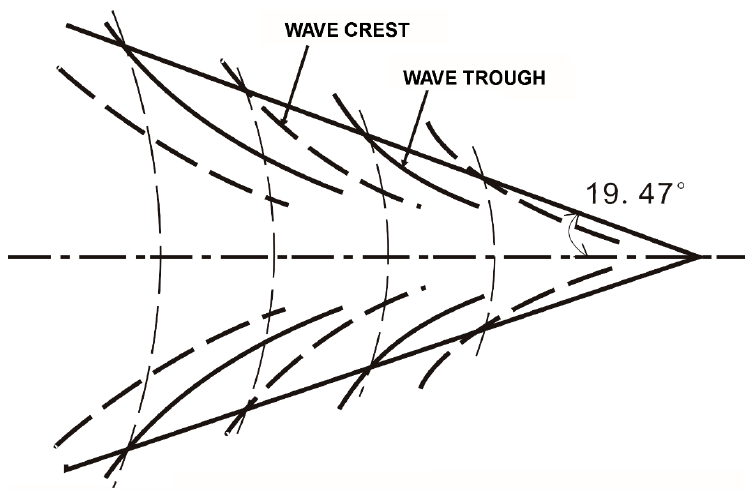
Figure 1. Kelvin wave patterns created by a small disturbance.